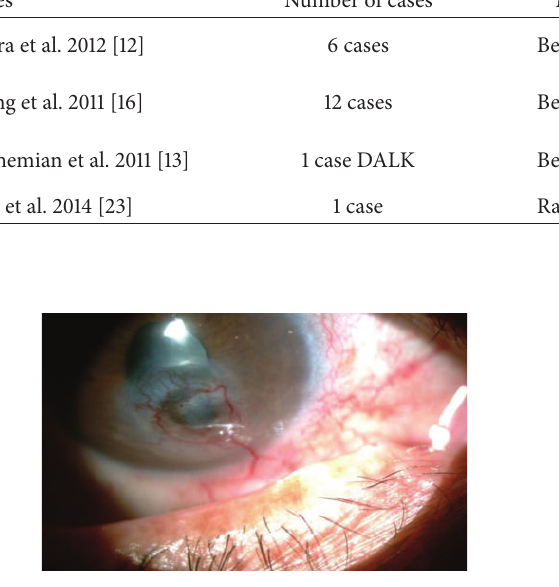
Figure 4: Corneal neovascularization in a patient with herpetic keratitis.